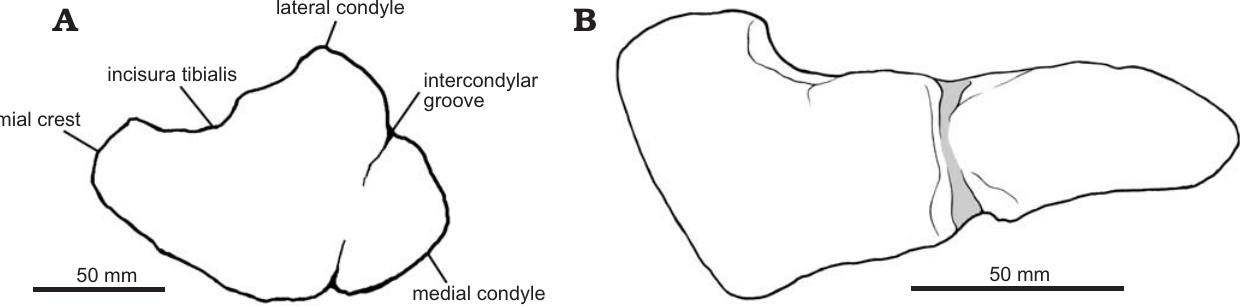
Fig. 9. Coelurosaurian theropod Phuwiangvenator yaemniyomi gen. et sp. nov. from the Early Cretaceous Sao Khua Formation of Phu Wiang, Khon Kaen Province, Thailand. A . SM-PW9B-41, right tibia in proximal view. B . SM-PW9B-40, left tibia in distal view. Light grey indicates broken